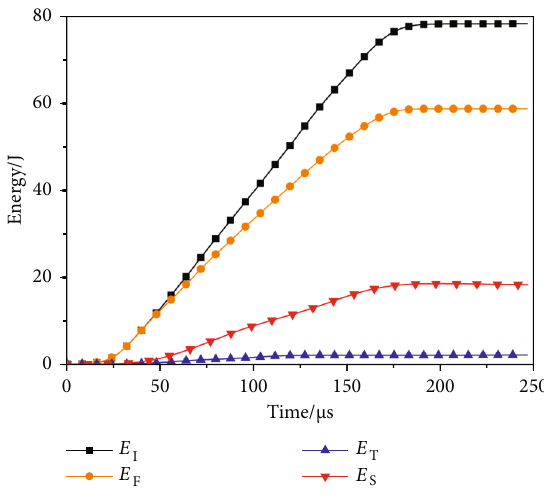
Figure 4: The typical energy-time curve of frozen sandy soil.